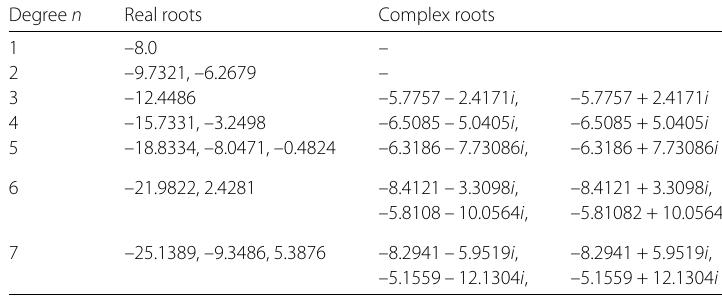
Table 11 Approximate solutions of H ( r ) F ( c , υ ) n ( x , y , z ) Degree n Real